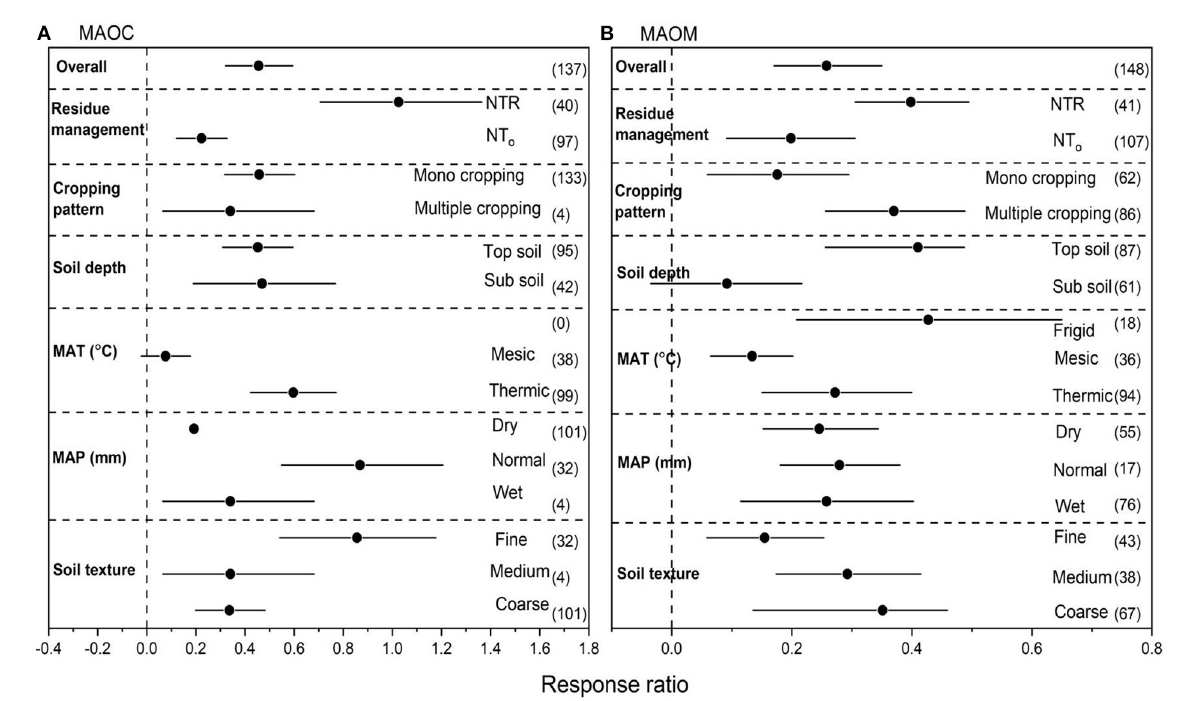
FIGURE2 (A,B) The effect size of mineral associated organic carbon (MAOC) and mineral associated organic matter (MAOM) with NT compared to CT. If 95% confidence intervals (CIs) do not overlap with zero, there is a substantial difference in the effect size between treatments. Error bars display CIs. The sample size for each variable is displayed next to each bar. The acronyms stand for mean annual temperature (MAT), mean annual precipitation (MAP), retention of residue (NTR), and no residue retention